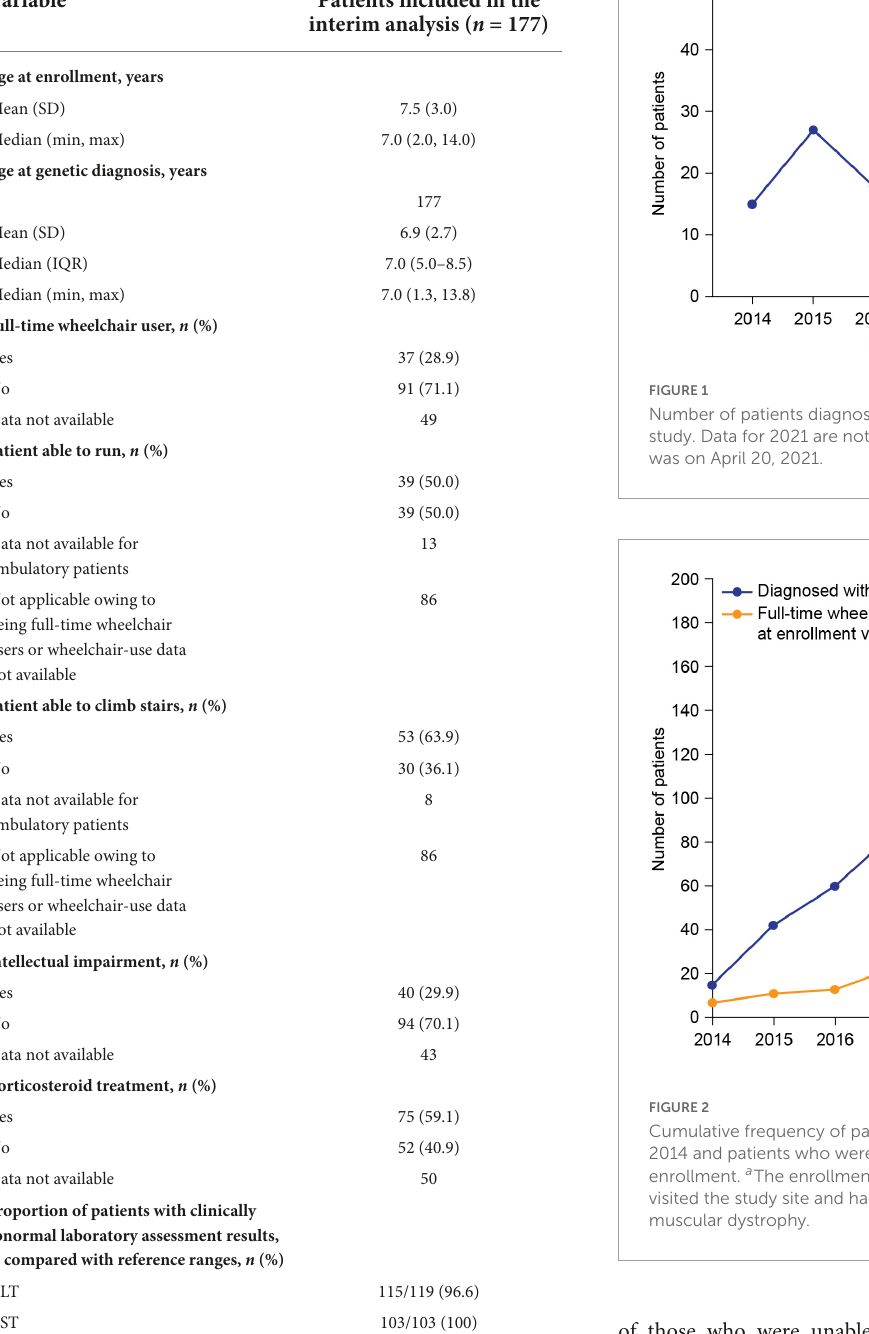
TABLE 1 Patient demographics and clinical characteristics.